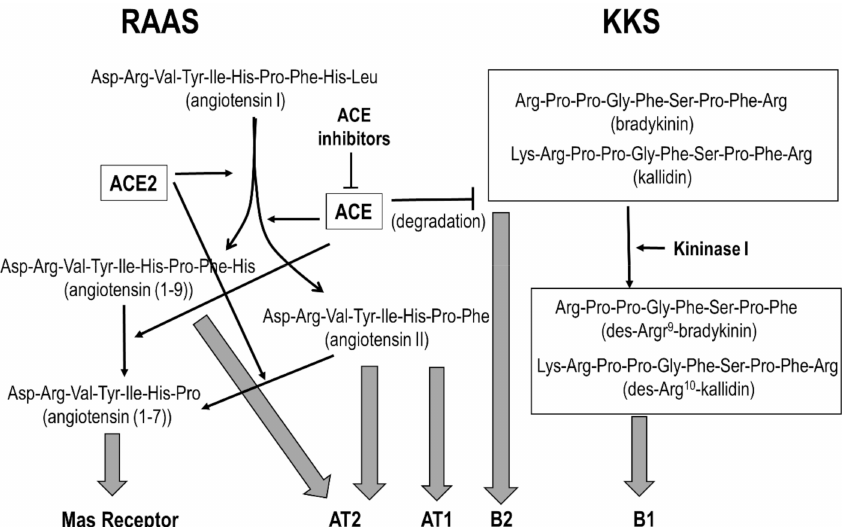
Figure 1. Crosstalk between RAAS and KKS. The angiotensin converting enzymes ACE and ACE2 are key players of RAAS, regulating the production of diverse mediators (see text), producing a plethora of physiological actions through the activation of di ff erent receptors (solid arrows). Thus, activation of the angiotensin AT1 receptor produces vasoconstriction, hypertrophy and fibrosis; whereas activation of the AT2 and Mas receptors produce vasodilation, antihypertrophy and antifibrosis. On the other hand, ACE regulates the levels of kinins that produce vasodilatation and increased vascular permeability through the B1 and B2